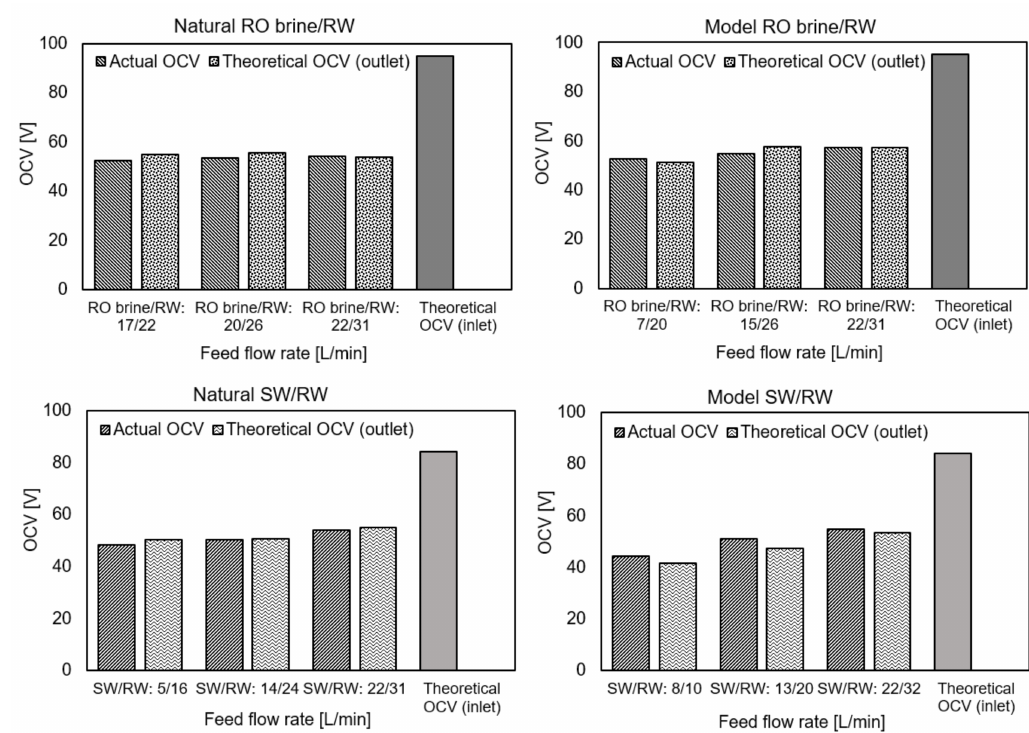
Figure 3. Actual and theoretical open circuit voltage (OCV) using natural and model feed